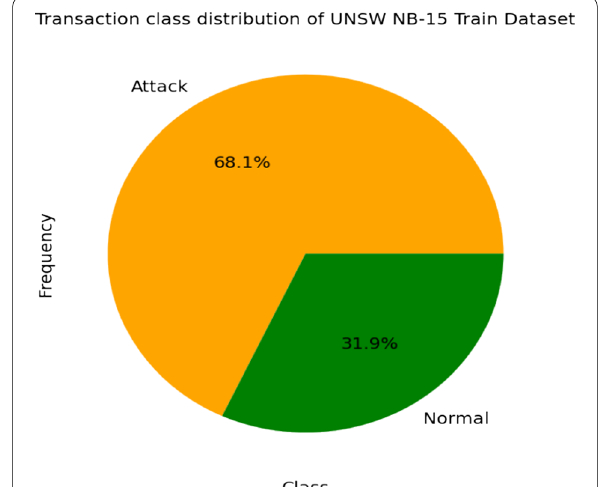
Fig. 2 Transaction class distribution of UNSW-NB 15 Train Dataset